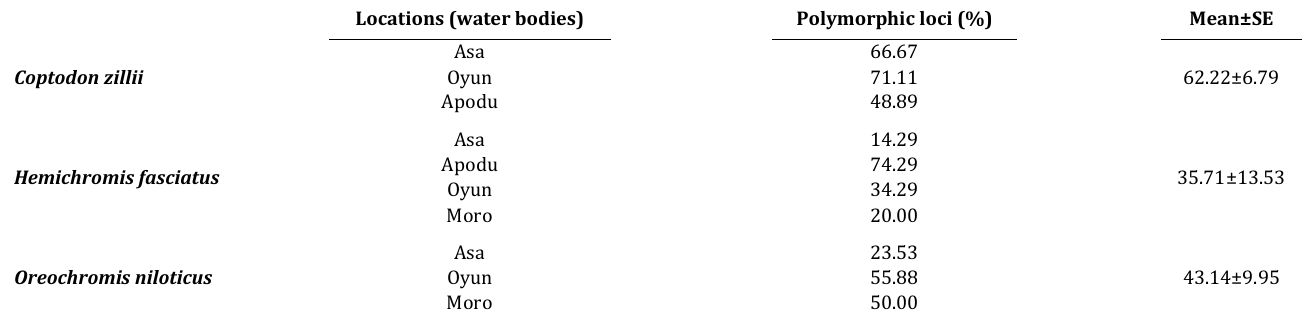
Table 2 . Percentages of polymorphic loci among Cichlid samples